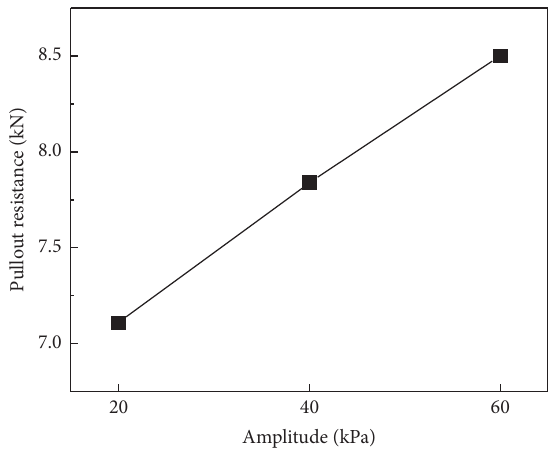
Figure 12: The curve of the amplitude versus pullout resistance.